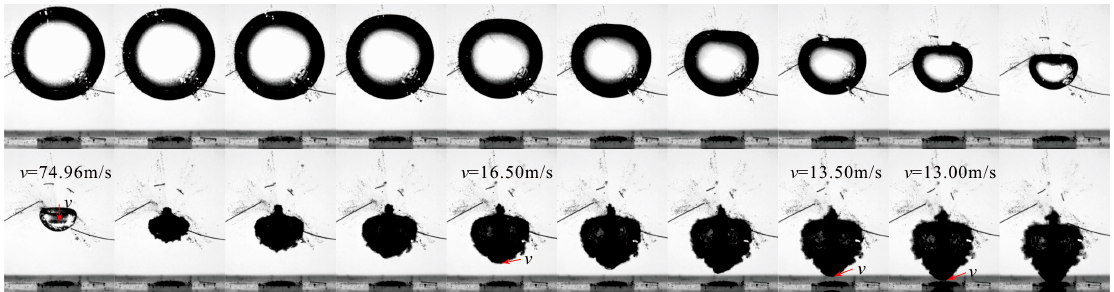
Figure 5. Process of the impact of micro-jet of rebound cavitation bubbles on a wall (frame-rate: 150,000 fps; exposure time: 5.06 μ s; R max = 11.02 mm, γ = 1.79).